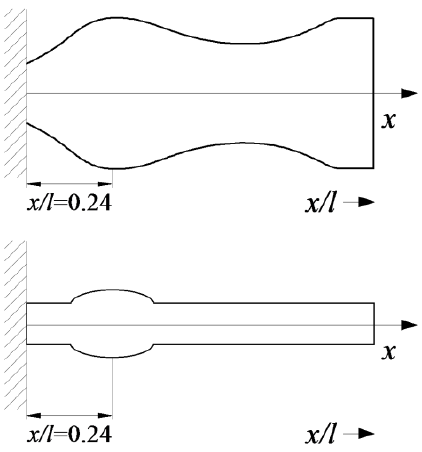
Figure 2. Schematics of the optimal OPT II − ( top ) and the proposed rational ( bottom ) vibration energy harvester (VEH) substrate harvester (VEH) substrate configurations.